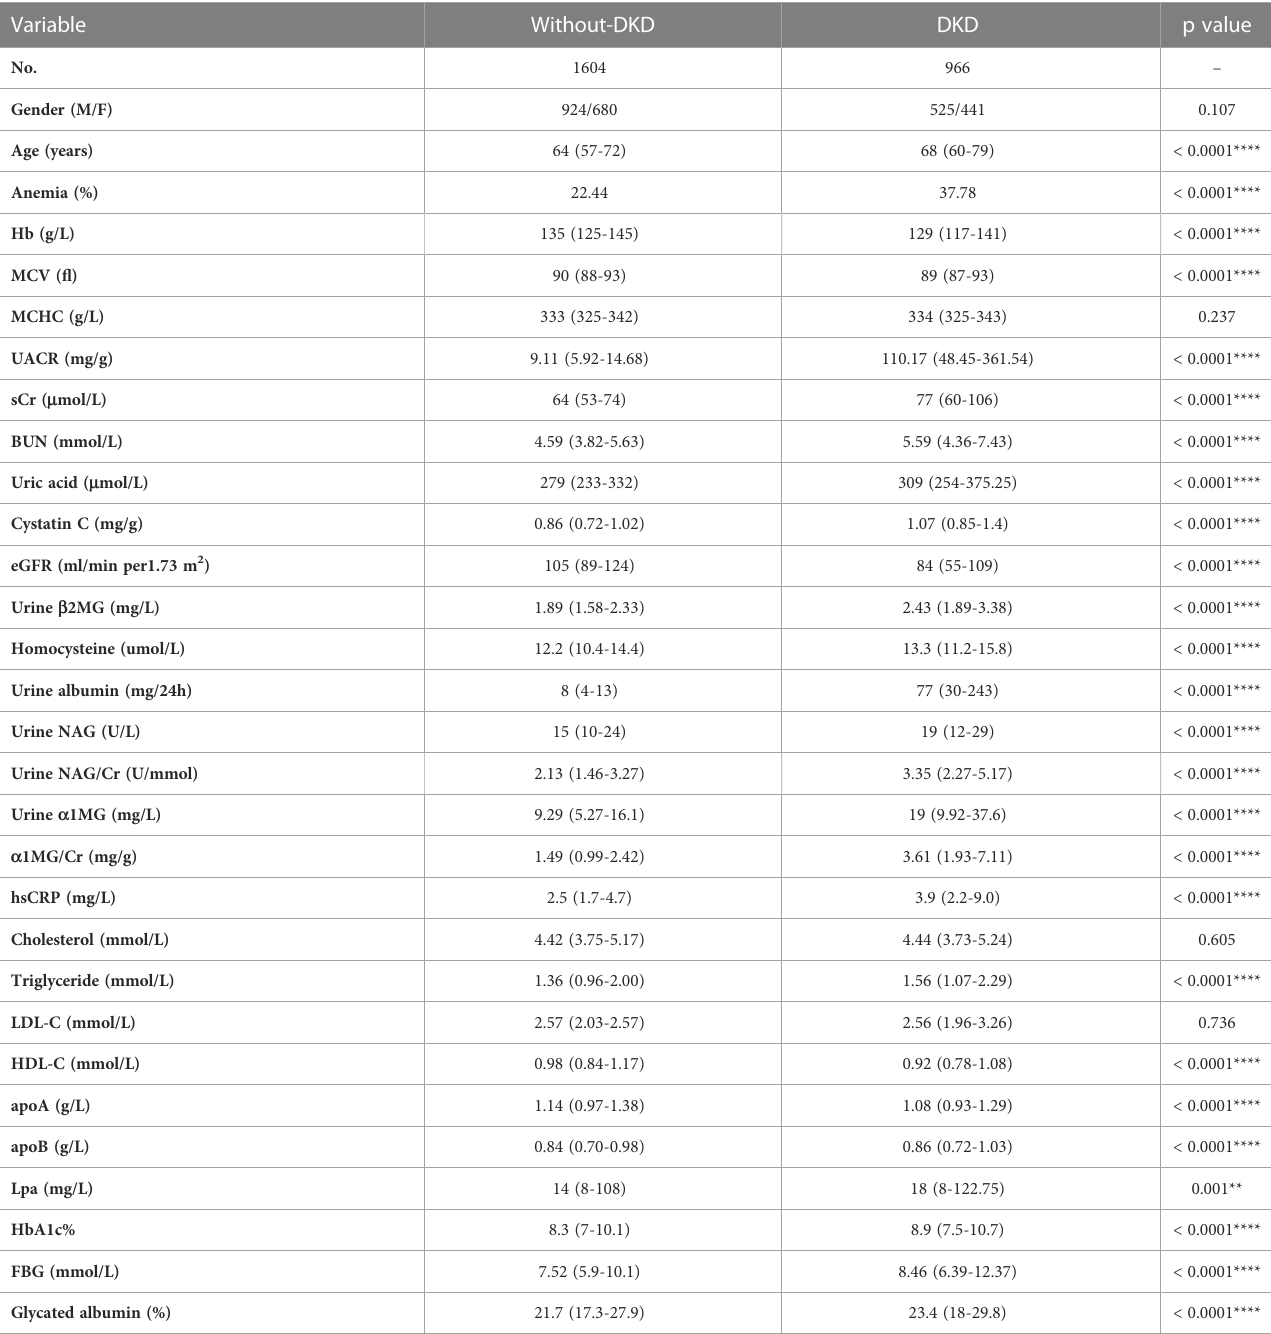
TABLE 1 Clinical characteristics of type 2 diabetic patients with or without DKD. Variable Without-DKD